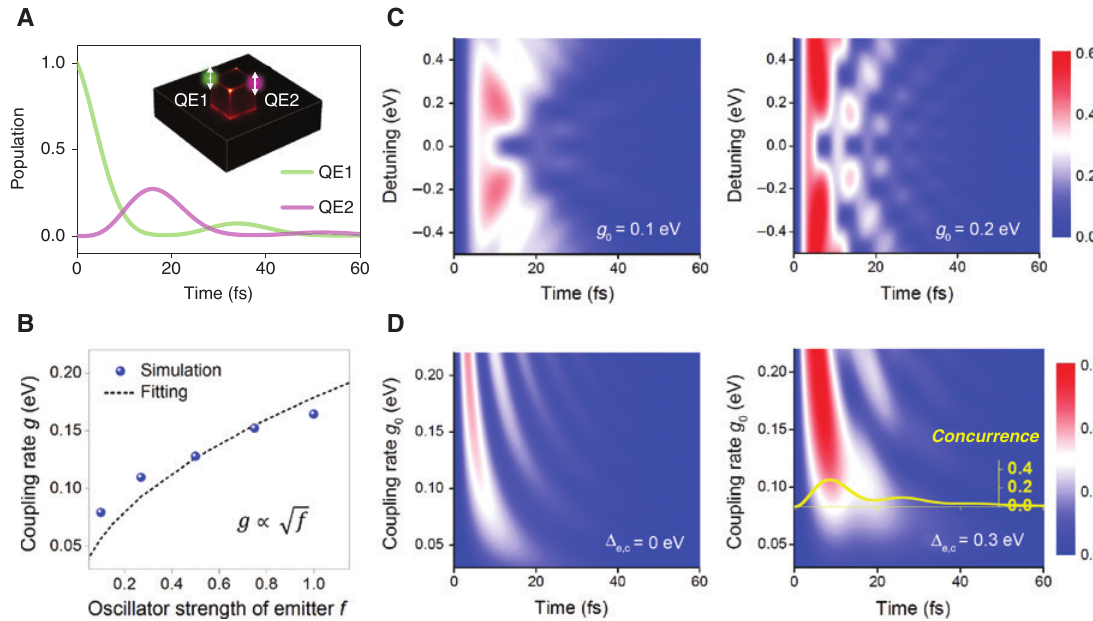
Figure 3: Antenna mode for qubit entanglement. = 0.08 eV and emitter-cavity detuning (A) Dynamics of the excited-state population when QE1 and QE2 are entangled, with coupling rate g 0 Δ = ω = 0. Inset, schematics of two-emitter entanglement in c -NCoM configuration. (B) Calculated collective coupling rate g for various – ω e,c e c types of QE layer with different oscillator strength f from FDTD simulations. The dashed line is fitted to . f (C) Dynamics of concurrence C at = 0.1 eV (left) and g = 0.2 eV (right). (D) Dynamics of concurrence different emitter-cavity detuning Δ , with single-emitter coupling rate g e,c 0 0 = 0 (left) and Δ = 0.3 eV (right). Inset, dynamics of C at different single-emitter coupling rate g , with the emitter-cavity detuning of Δ 0 e,c e,c = 0.08 eV. In this study, the resonant frequency of cavity is fixed at ω = 1.94 eV (640 nm) concurrence C at the single-emitter coupling rate g 0 c = 0.04 eV, from Figure 2A. The decay rates of cavity and emitters are chosen as κ = 0.08 eV and γ e1(2)